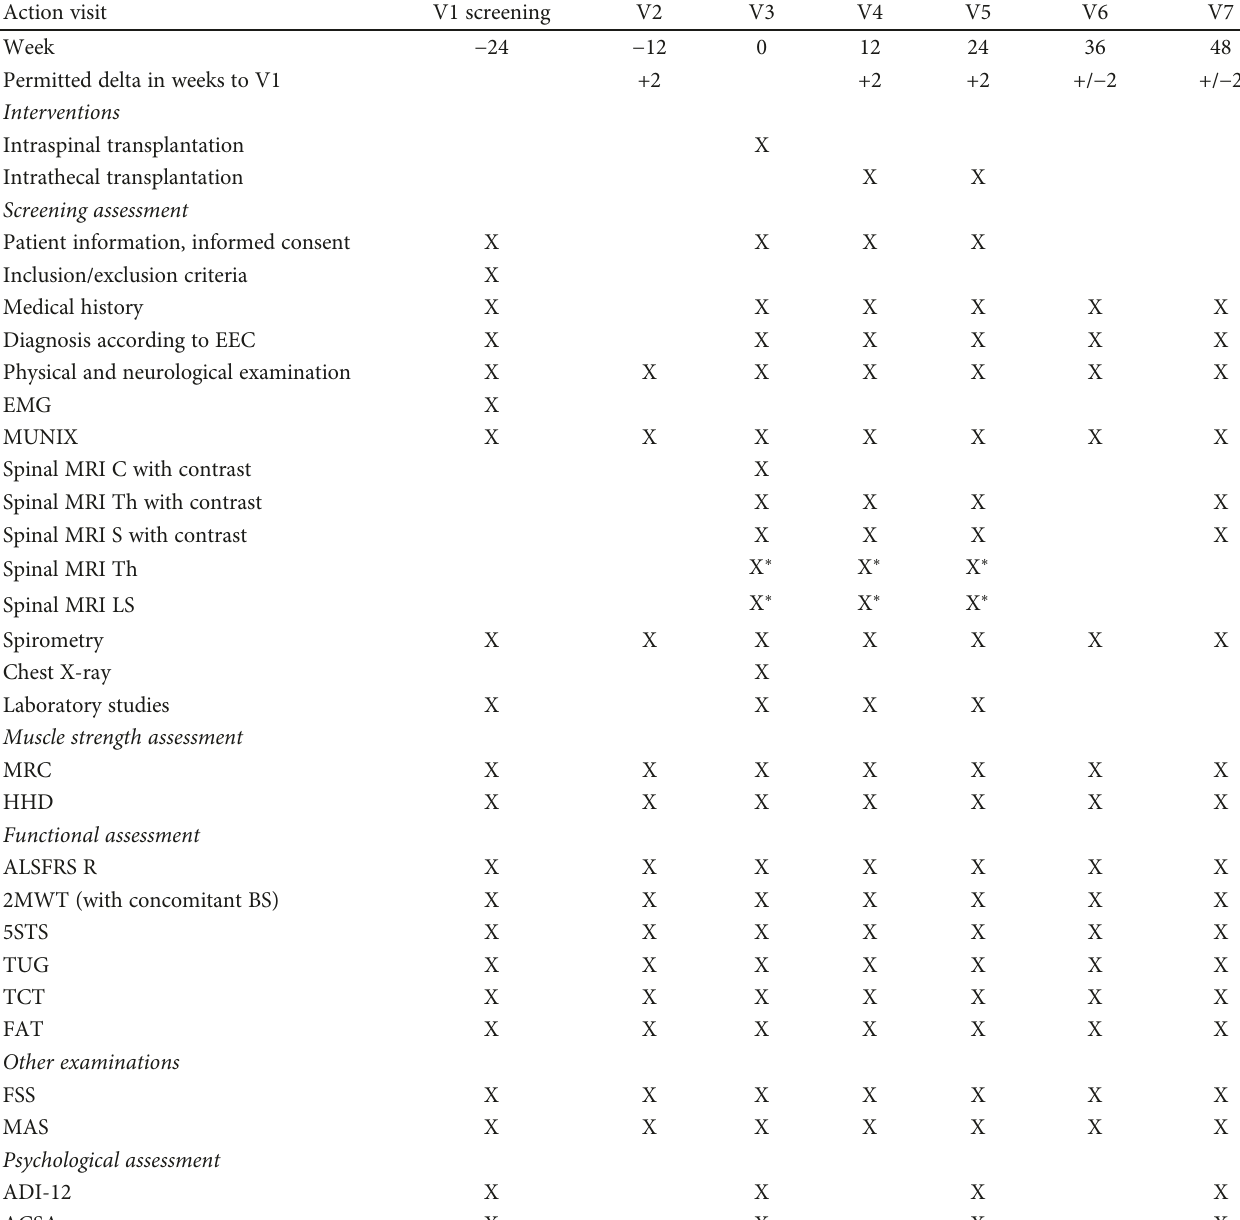
Table 2: Timetable of the adipose-derived regenerative cell (ADRC) isolation and transplantation